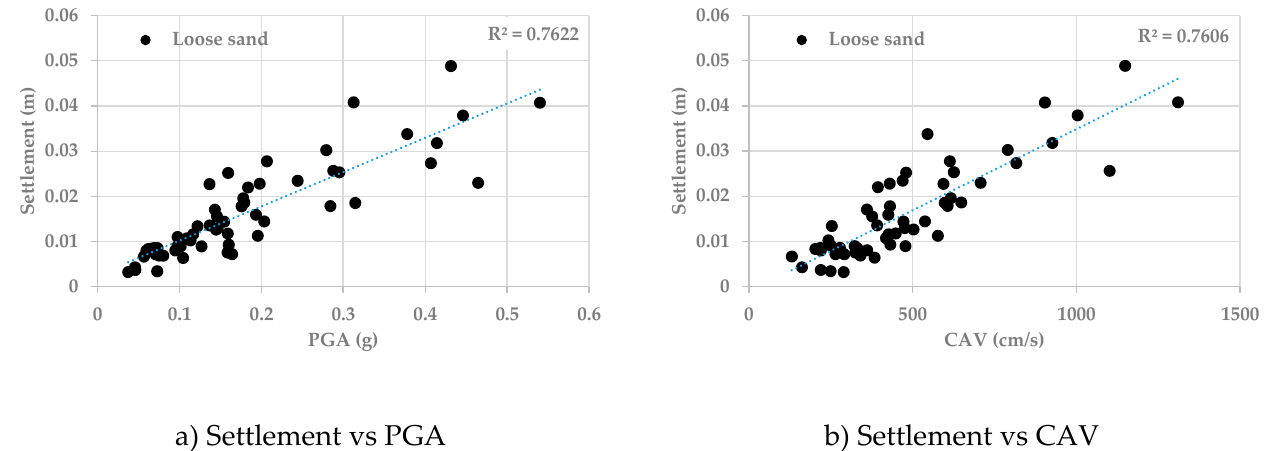
Figure 3. Comparison of the relationships between liquefaction-induced settlement and PGA and liquefaction-induced settlement and CAV.